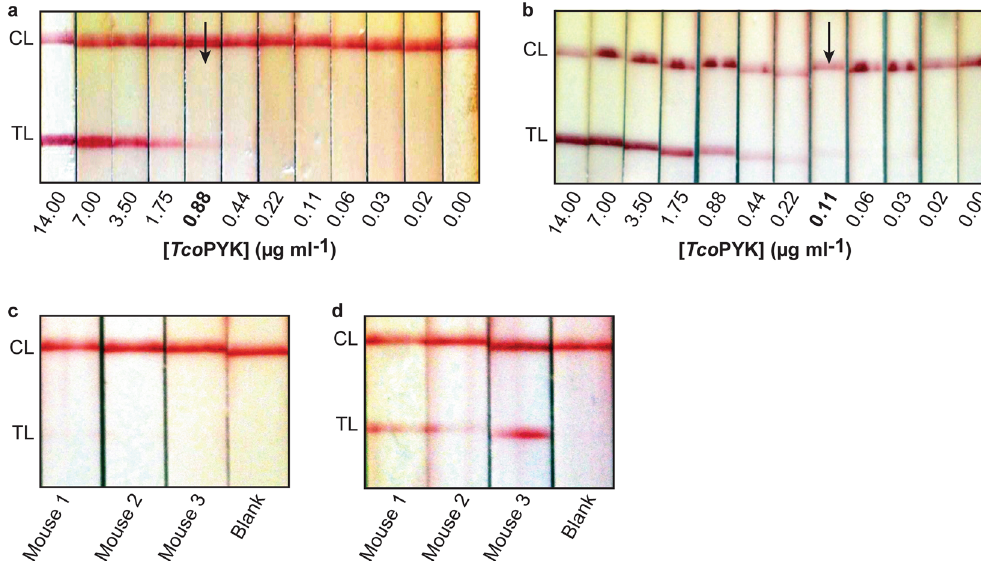
Figure 7. The Nb44/Nb42 LFA can be employed to detect experimental T . congolense infections in cattle. ( a , b ) LFA read-outs for naive cattle serum spiked with a dilution series of Tco PYK using monovalent Nb44-AuNPs ( a ) and bivalent Nb44-Nb44-AuNPs ( b ). In both cases, the samples were diluted three-fold in PBS containing 1% methylcellulose and 1% Tween20. ( c , d ) LFA read-outs for sera from mice infected with T . congolense using monovalent Nb44-AuNPs ( c ) and bivalent Nb44-Nb44-AuNPs ( d ). In both cases, the samples were diluted three-fold in PBS containing 1% methylcellulose and 1% Tween20. In all LFAs, the test line consists of a streptavidin-based coating of biotinylated Nb42. The visual LoD was established based on the last Tco PYK concentration at which a TL band could be observed (indicated by the black arrow). 50 μ l of sample was spotted onto the sample